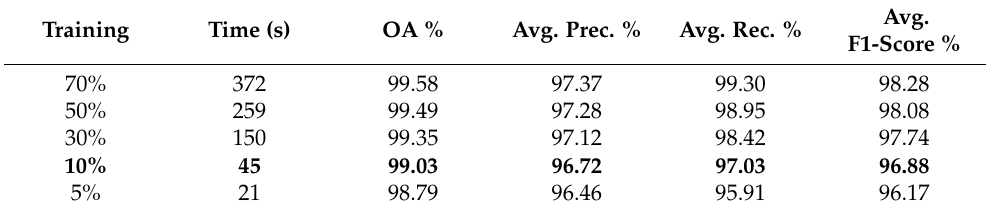
Table 5. Comparison of different sizes of training dataset. Bold values are close to 99% overall accuracy.